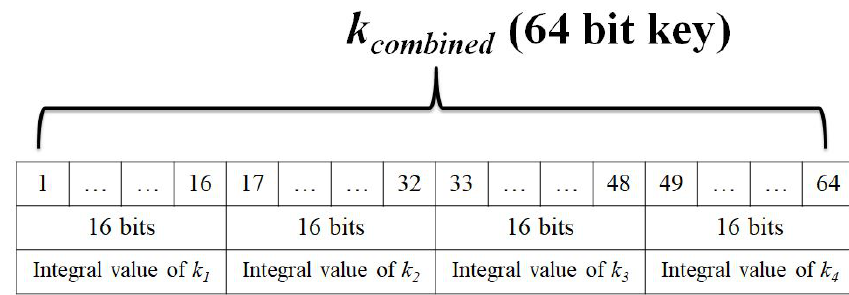
Figure 6. Calculation of key k combined by using k 1 , k 2 , k 3 , and k 4 .